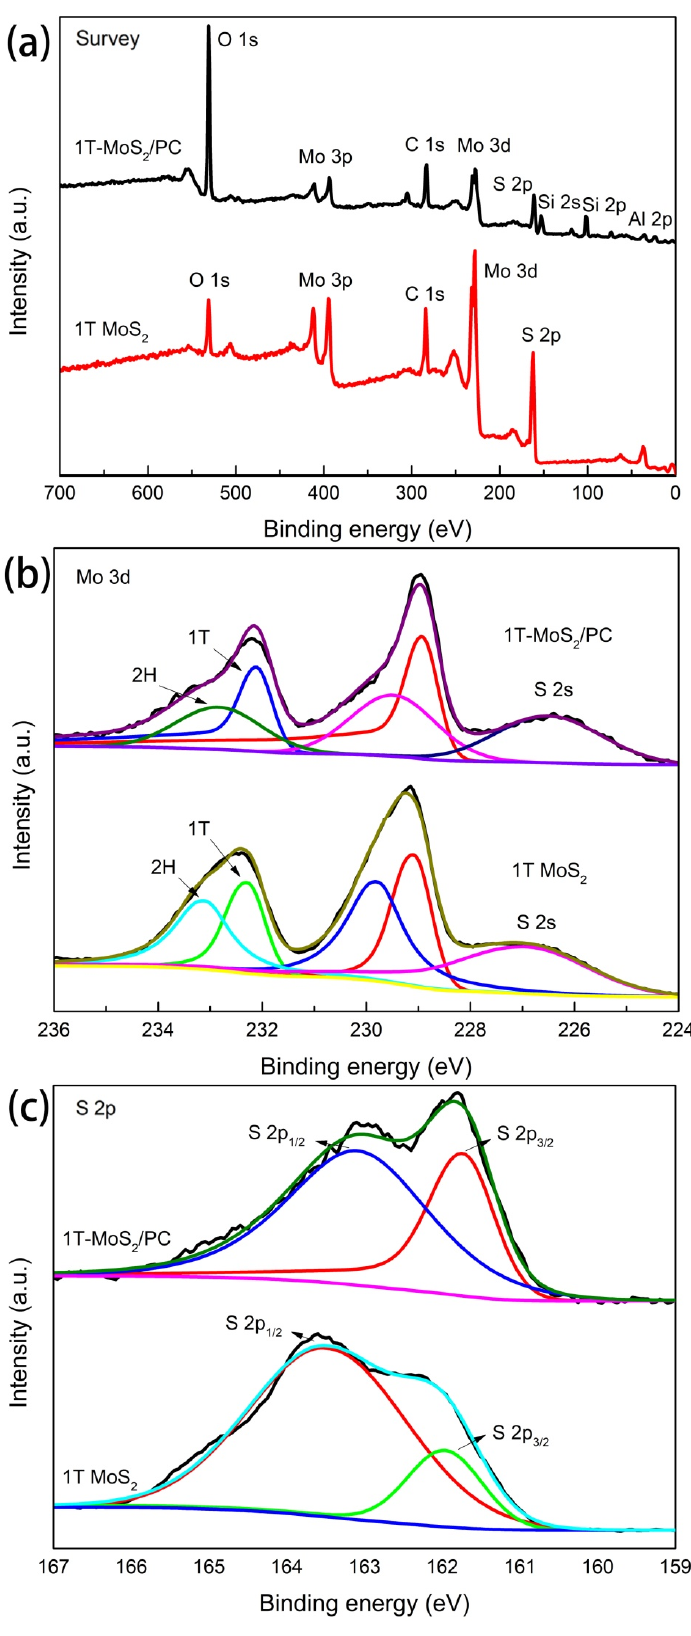
Figure 4. ( a ) XP survey spectra of 1T-MoS 2 /PC and 1T-MoS 2 . High-resolution scans for ( b ) Mo 3d and ( c ) S 2p.